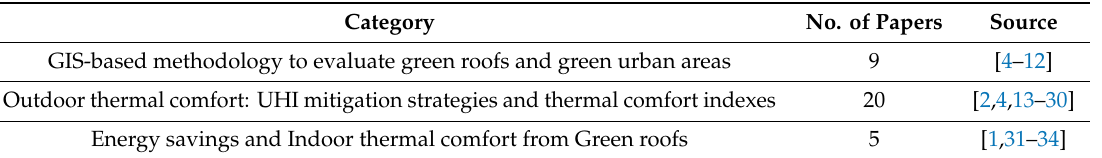
Table 1. Literature review on the impact of green roofs and green urban areas on indoor and outdoor thermal